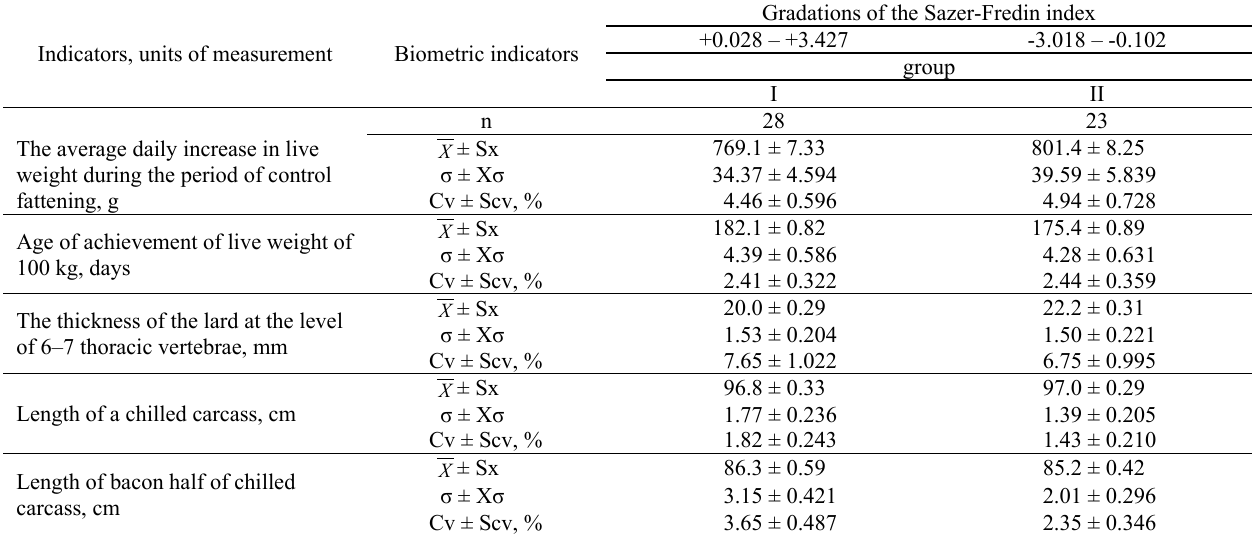
Fattening and meat qualities of young pigs of Large White breed of different intrabreed differentiation according to the Sazer- Fredin index